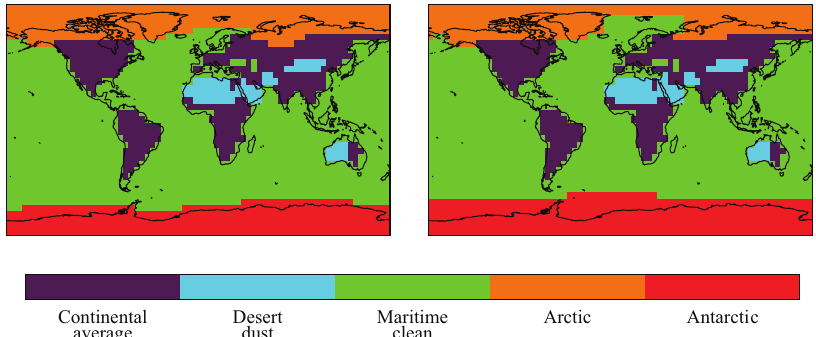
Fig. 1. The spatial distribution of aerosol types used by GRAPE. The left map shows the distribution used for Southern Hemisphere summer (October–March), the Northern Hemisphere summer (April–September) is given on the right.